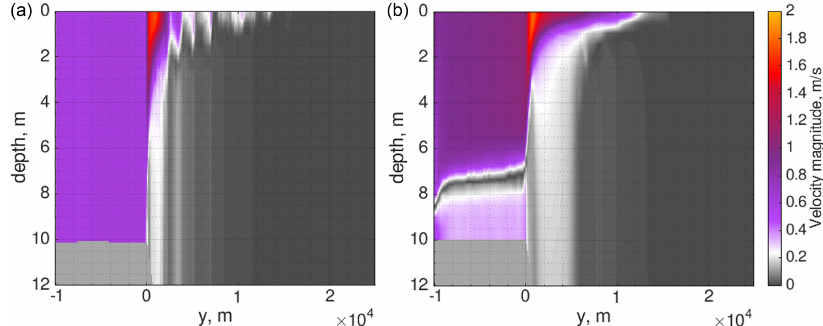
Figure 4. The magnitude of the velocity at the mouth cross section based on runs 1 (a) and 2 (b) at the 20h time moment.